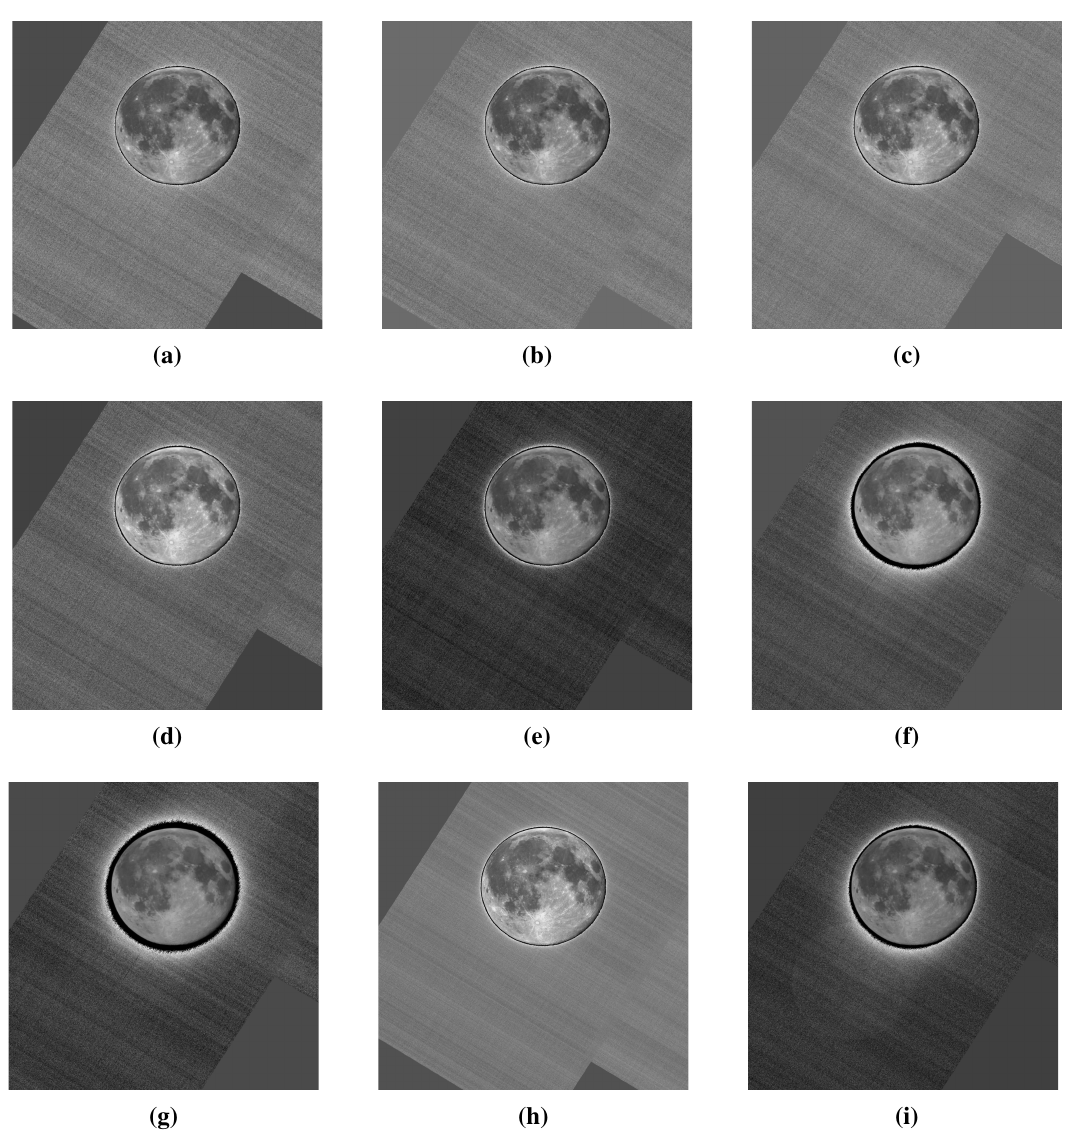
Figure 18. Lunar acquisitions with contrast stretched to show signs of stray light or other artifacts. ( a ) Coastal Aerosol. ( b ) Blue. ( c ) Green. ( d ) Red. ( e ) Near Infrared. ( f ) SWIR 1. ( g ) SWIR 2. ( h ) Pan. ( i )